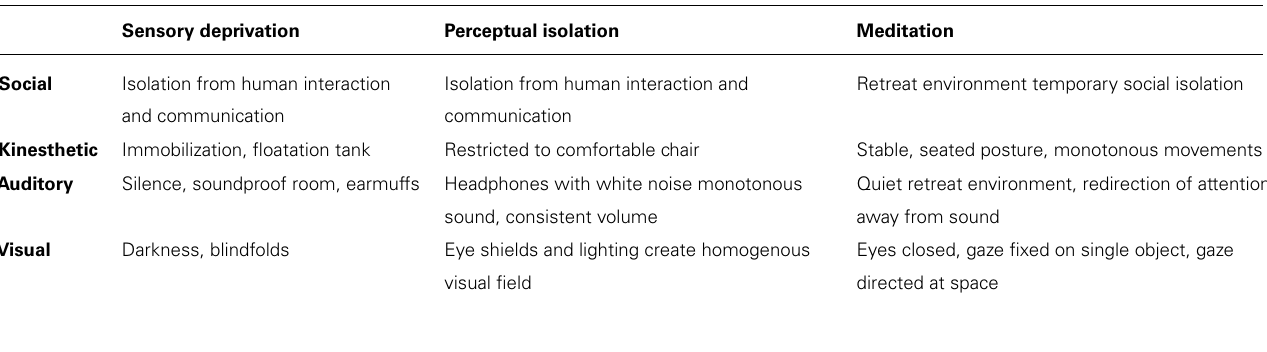
Visual Darkness,